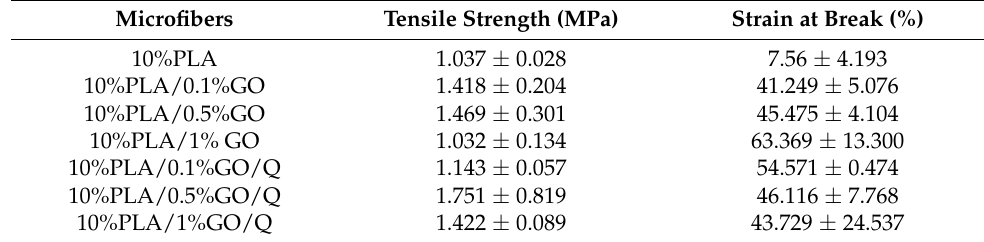
Table 2. Mechanical test results obtained from the tensile